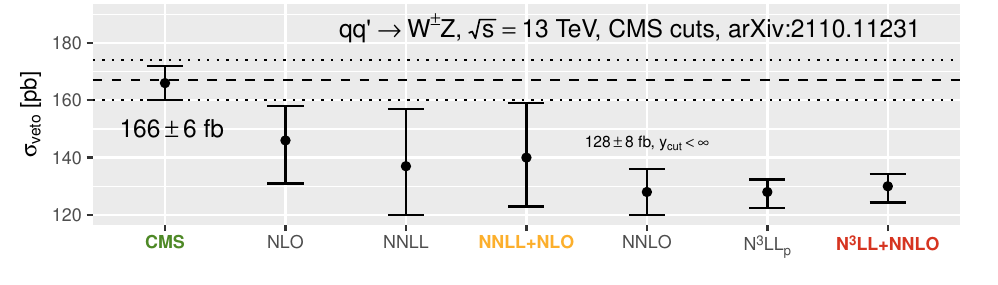
Figure 15 . Comparison of W ± Z jet-vetoed predictions with the CMS [45] 13 TeV measurement. Shown are results at fixed-order, purely resummed and matched, all without a rapidity